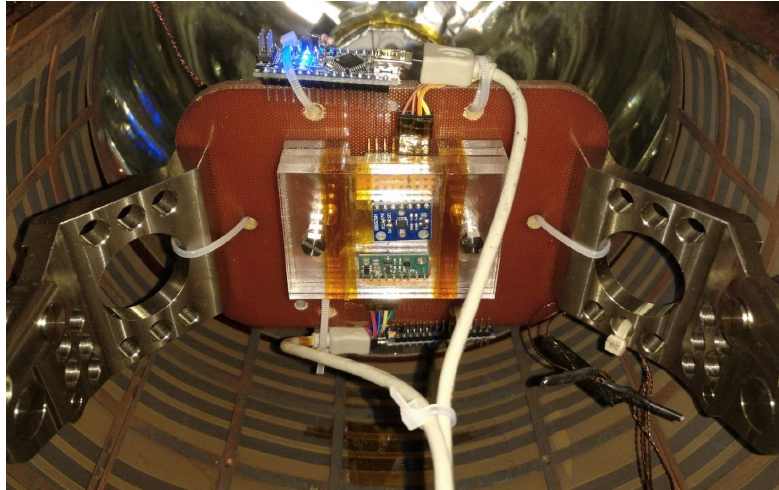
Figure A1. Detailed inside view of the measurement box (magnification of Figure A2a). The two sensors in the middle of the picture are being tested. Data transfer and current supply are provided by USB cables; primary data processing is taking place in the arduino boards placed on top and at the bottom of the holding plate. Downwards and right of the holding plate, three wires with black tape on their ends can be seen; those are three of the eight temperature sensors inside the measurement box.